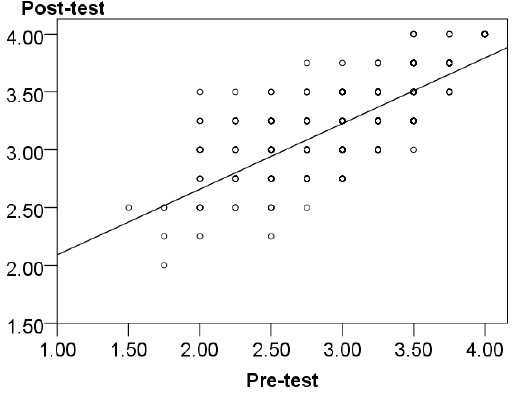
Fig. 4. Scatter plot of pre- and post-test scores